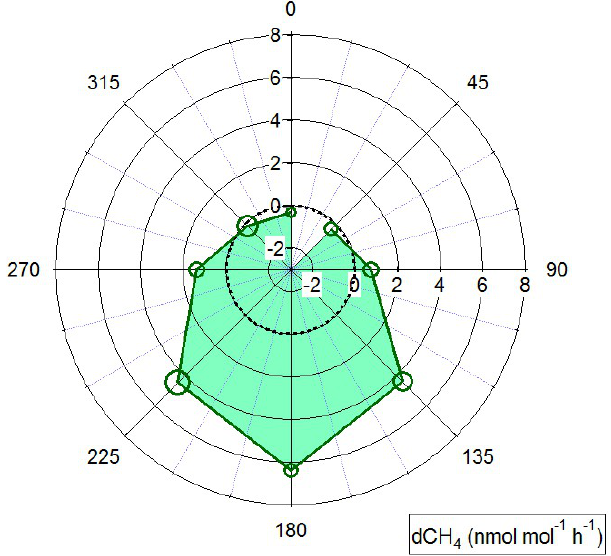
Fig. 6. Polar plot of bin-averaged (each 45 ◦ wind direction) slope of the change in CH 4 mixing ratio between 00:00 and 05:00 from each day during the measurement period with each size of the cir- cular markers indicating the number of points within the bin (8–19 points).